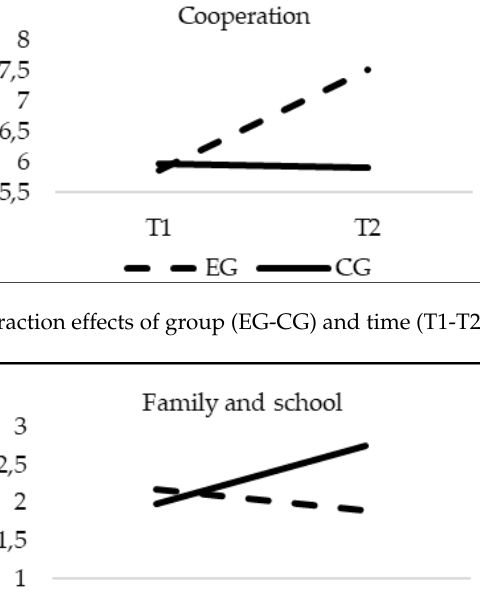
Figure 7. Interaction effects of group (EG-CG) and time (T1-T2) in Sense of belonging. Int. J. Environ. Res. Public Health 2019 , 16 , x